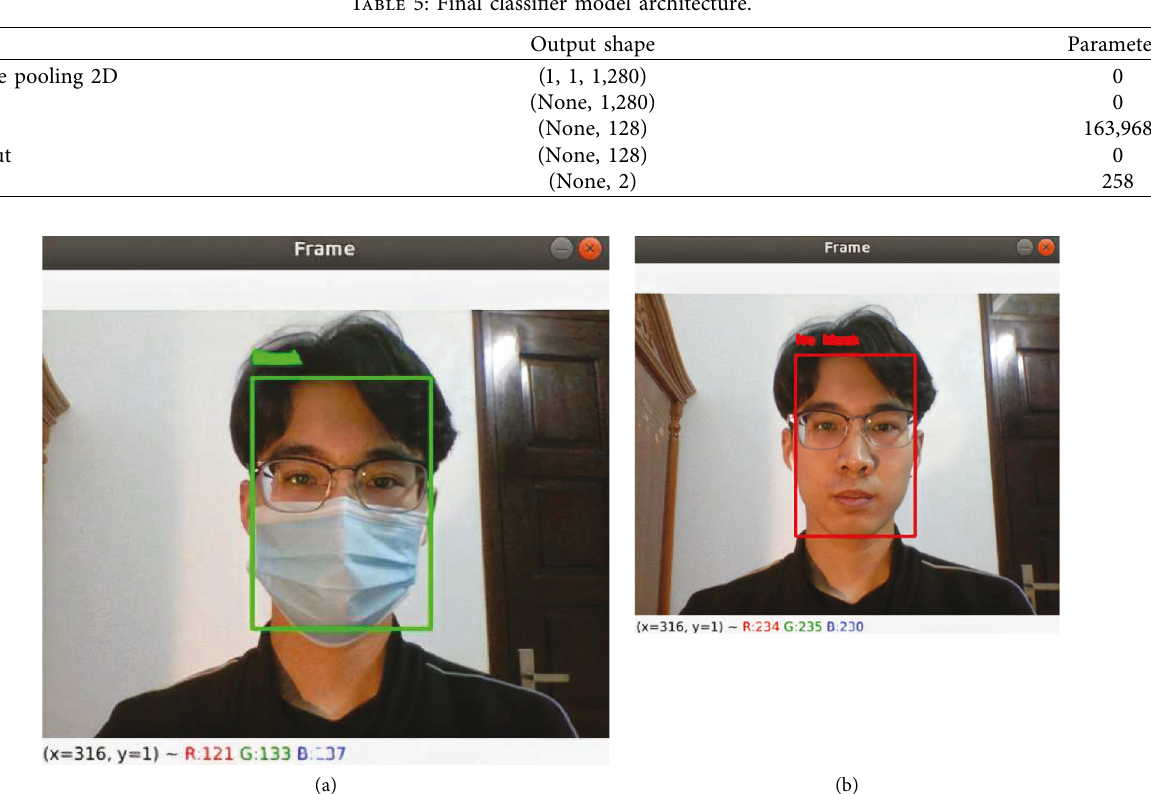
Figure 23: Result on webcam video: (a) with mask and (b) without